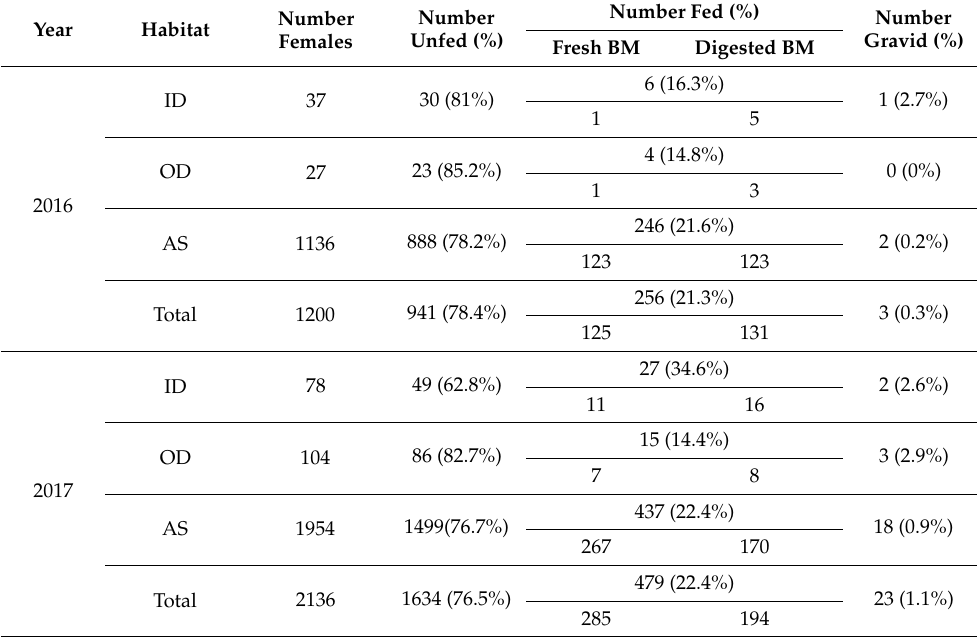
Table 2. Physiological state of female specimens according to habitat and year of